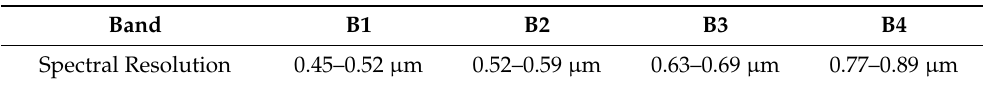
Figure 2. ( a ) Remote sensing image (GF-1 WFV, February 2016) and ( b ) surface classification (GlobeLand30) of Sindh Province. Table 1. Spectral resolution of GF-1